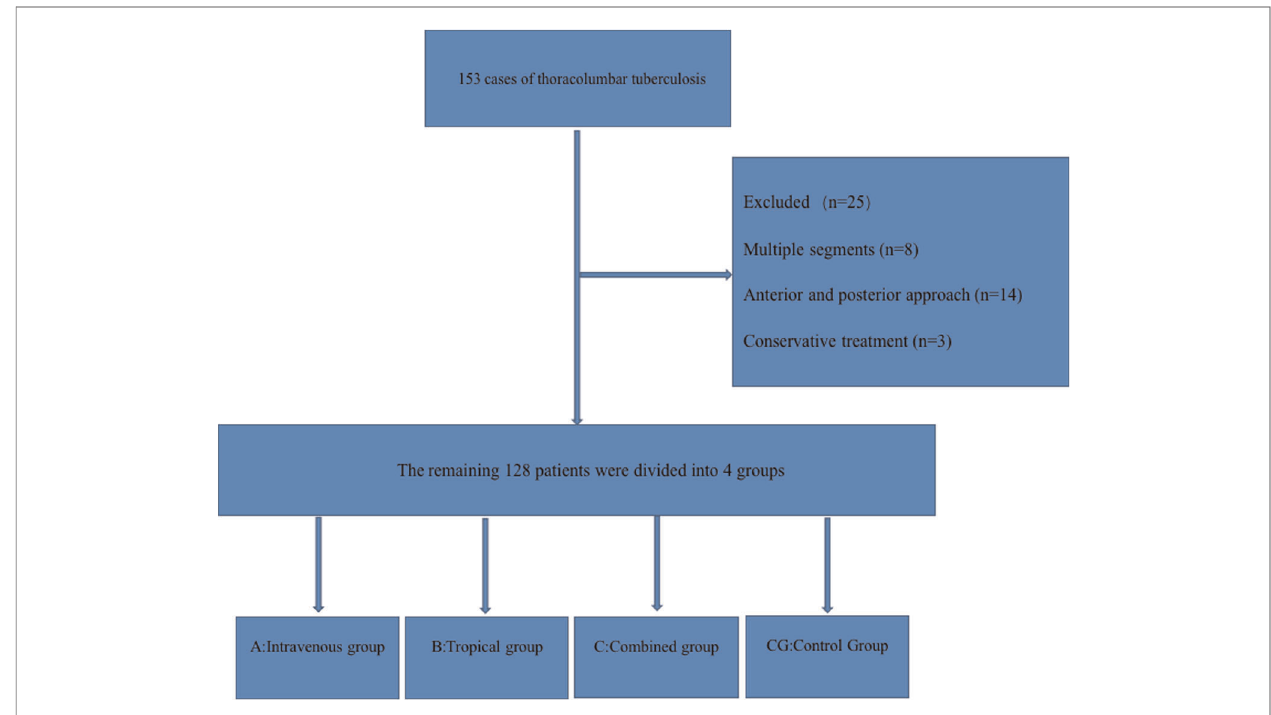
FIGURE 1 | Experimental fl ow